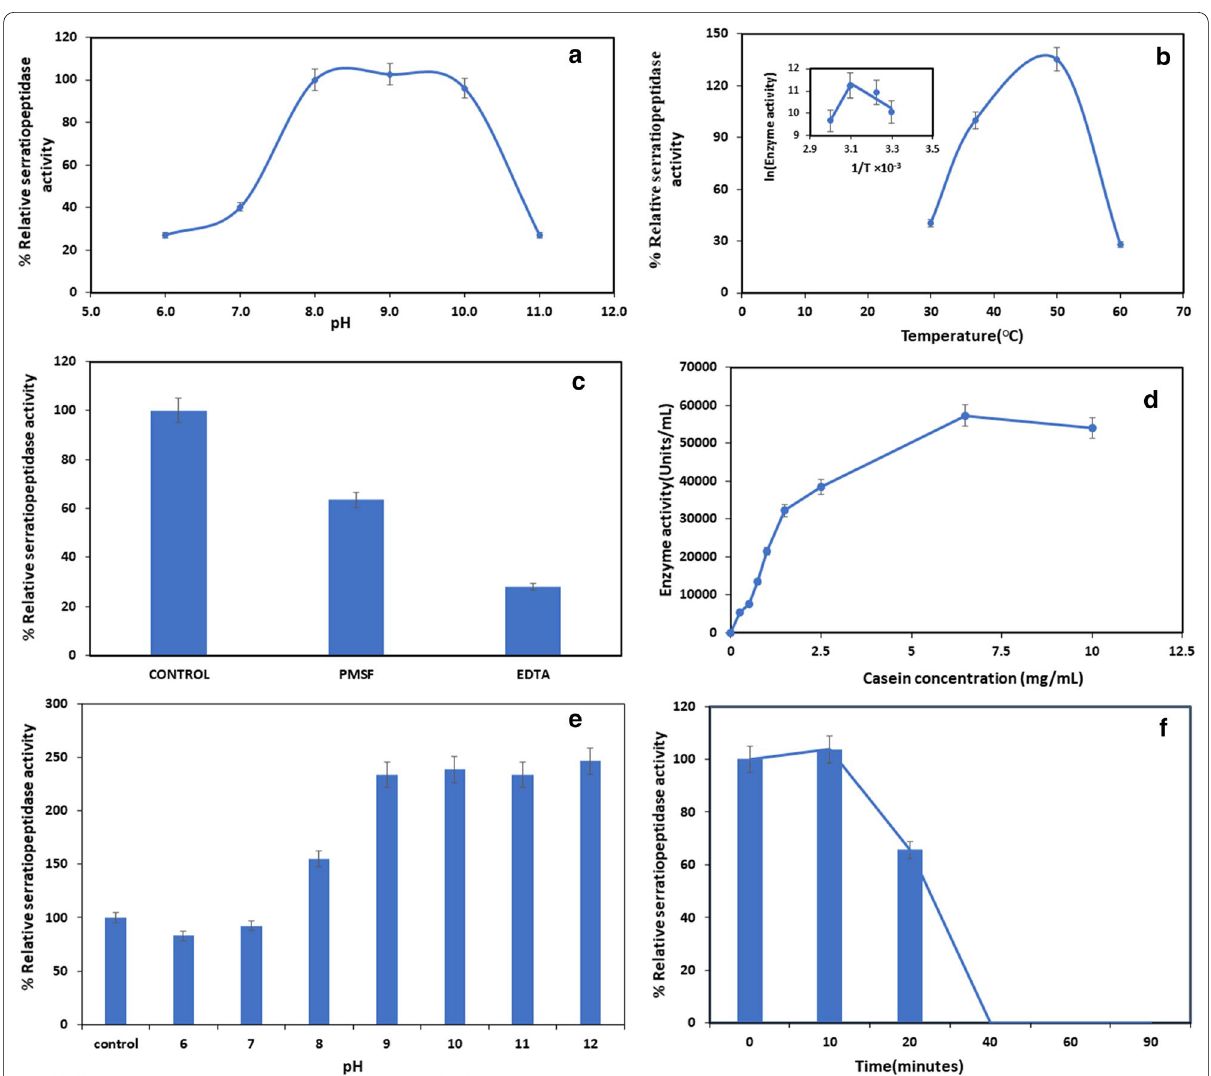
Fig. 5 Effect of various reaction conditions and stability of serratiopeptidase from S. marcescens AD-W2: a pH; b temperature (Arrhenius plot shown in inset); c inhibitors d substrate concentration; e pH stability; f temperature stability at 50